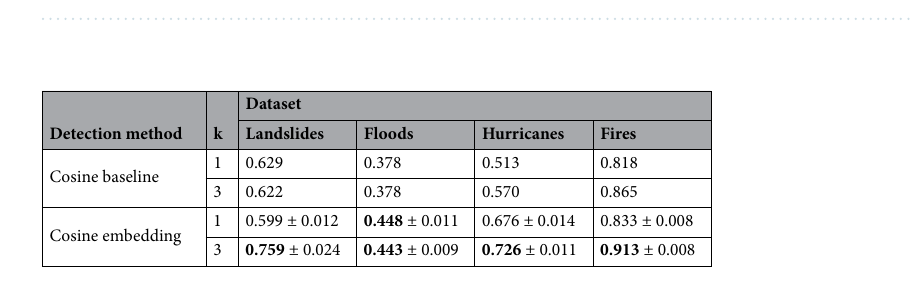
Table 4. AUPRC for the best performing metrics from Table 3 with and without an extended history k (averaged over 5 runs).